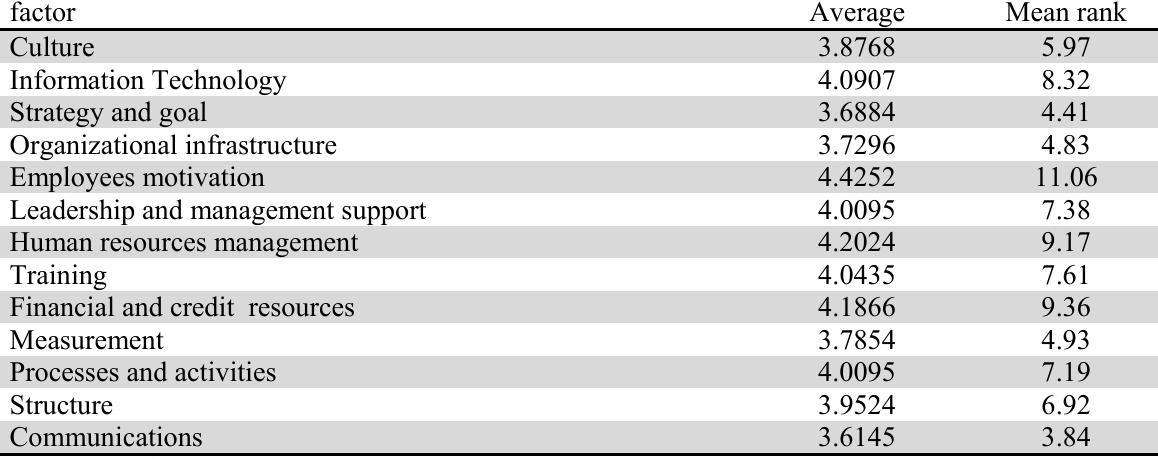
Comparison and prioritization of the success factors of using tools in the knowledge management cycle of the university under